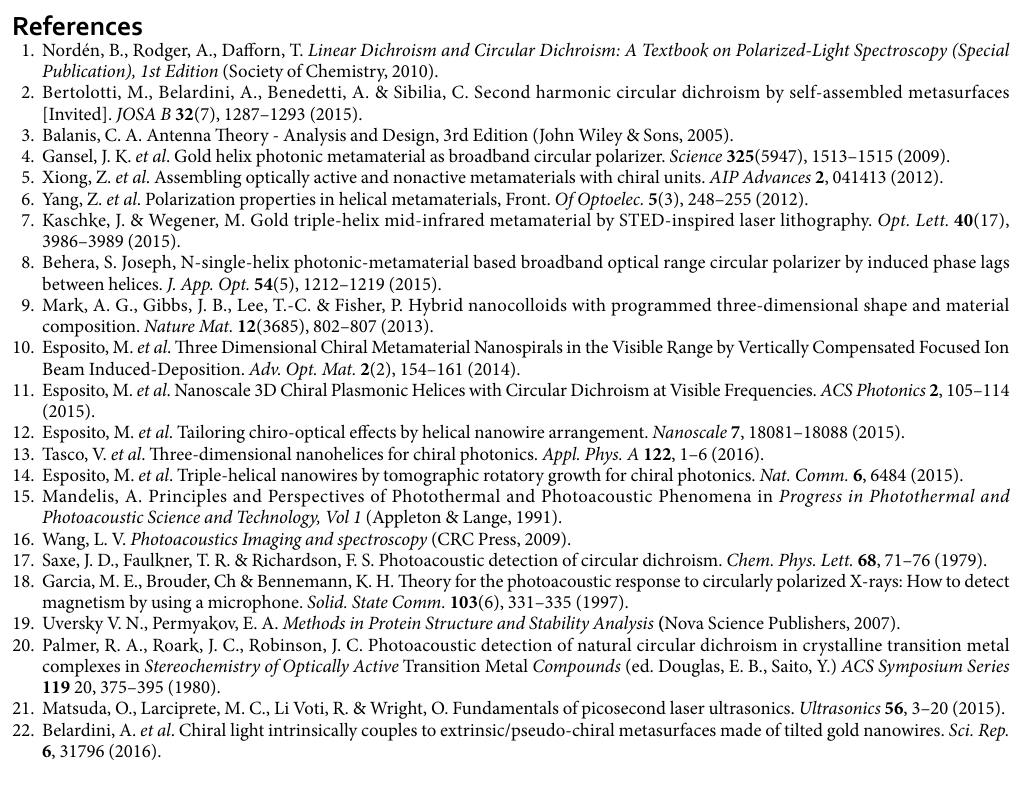
levels and a good impedance match, acting as a wide band effective filter for circular dichroism both for the trans- mitted fields and the absorbed power.